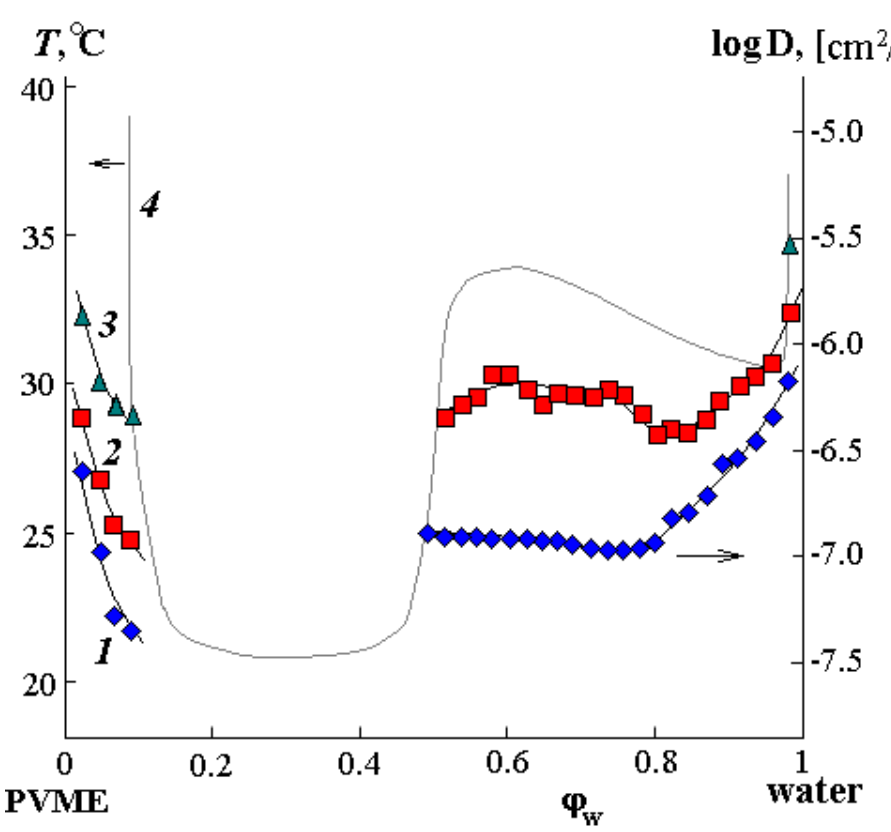
Figure 9. Concentration dependence of the interdiffusion coefficient for the PVME-water system at 25 °C (1), 30 °C (2), and 35 °C (3)—axis on the right. 4—phase state diagram (left axis).